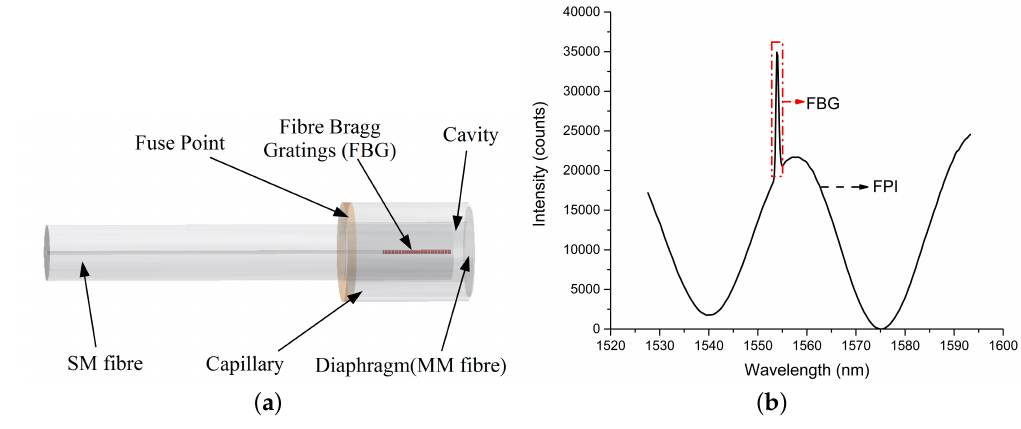
Figure 1. ( a ) Schematic of the Extrinsic Fabry Perot Interferometer (EFPI)/Fibre Bragg Gratings (FBG) sensor; ( b ) Reflection spectrum of the sensor showing EFPI and